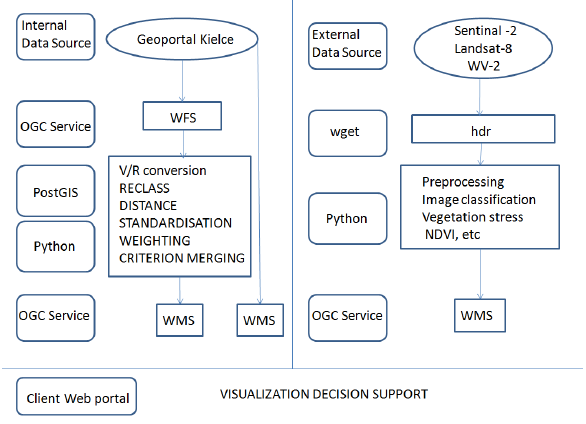
Figure. 2 Schema of Geoportal Kielce development S-AC Plugin (speed& quality). On the base of MTL metadata file Landsat 8 images were automatic transformed to reflectance, atmospheric corrected with DOS algorithm, transformed to the temperature and pansharpened. Images quality was improved using Minimum Noise Fraction (MNF) transformation (Green et al. 1988). Then images were